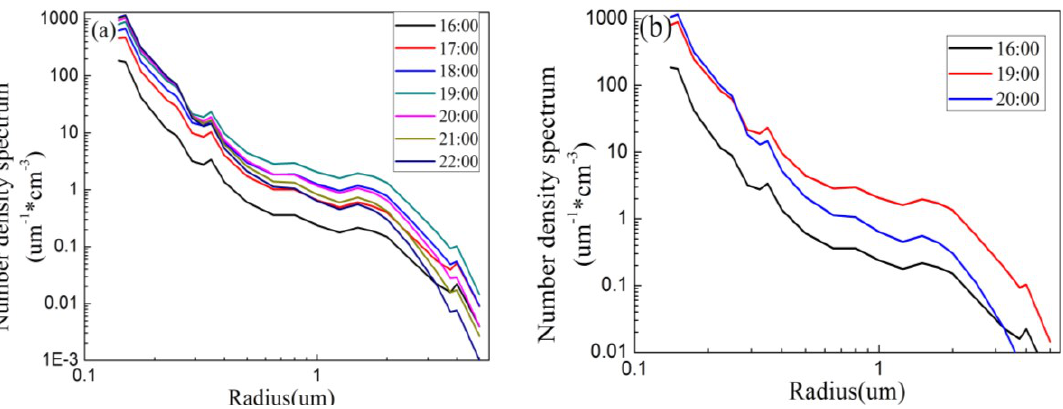
Figure 8. Aerosol particle spectrum distribution during the fog-haze ( a ) and at three different points in time ( b ).